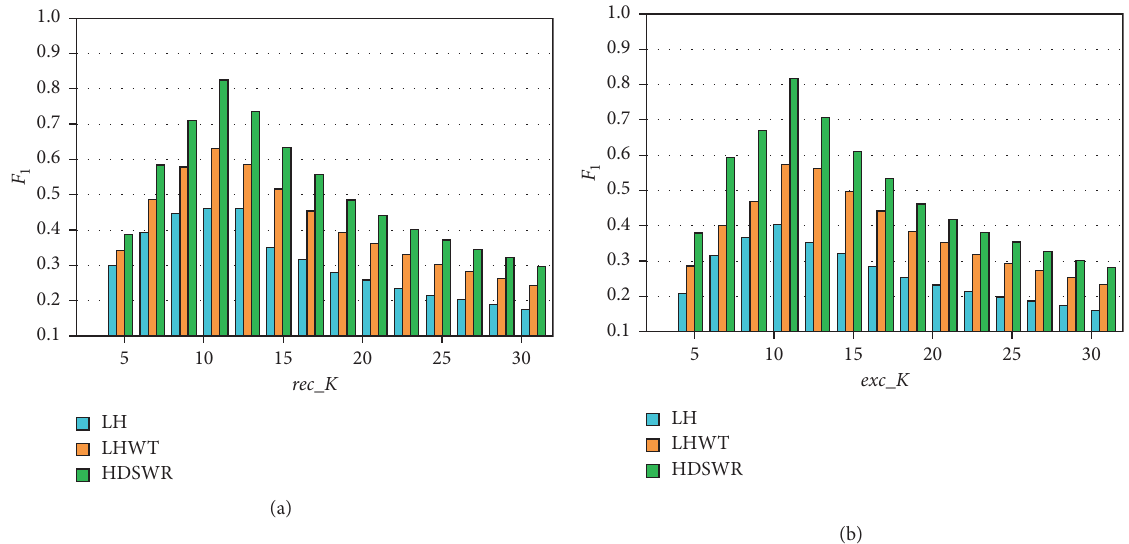
Figure 8: Efficiency comparison of different recommendation methods on the dataset SW#236. Table 3: Experimental results on the comparison of average running time (in seconds).